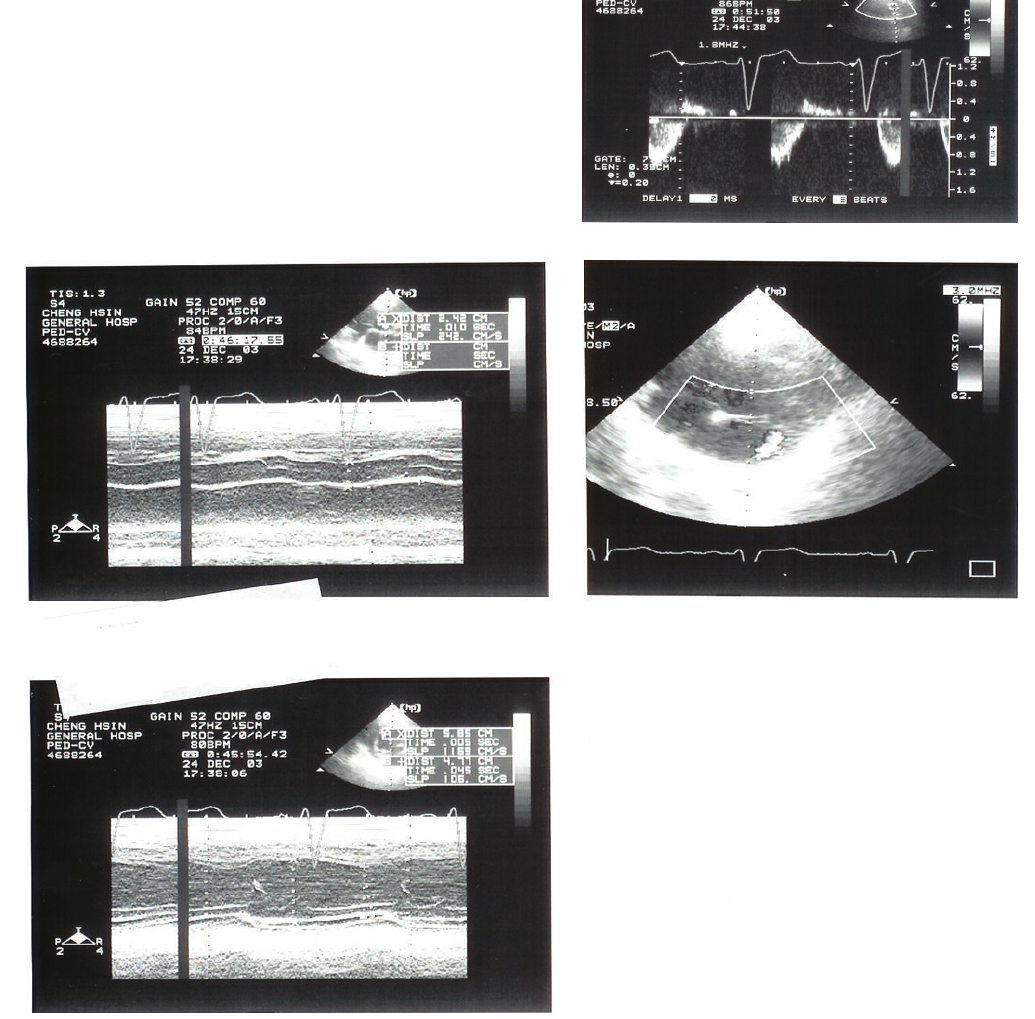
Figure 1: Echocardiographic representation indicating the abnormal opening of the left coronary artery inside the main pulmonary trunk.